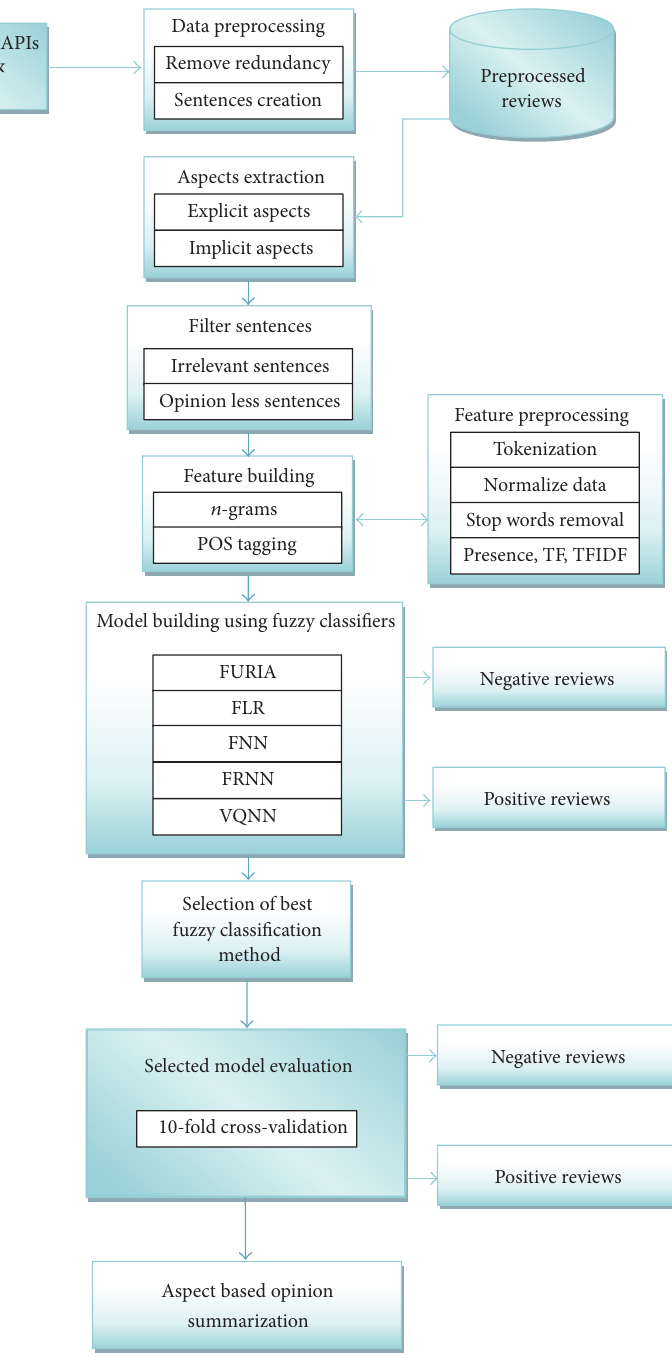
Figure 1: Proposed system for aspect based